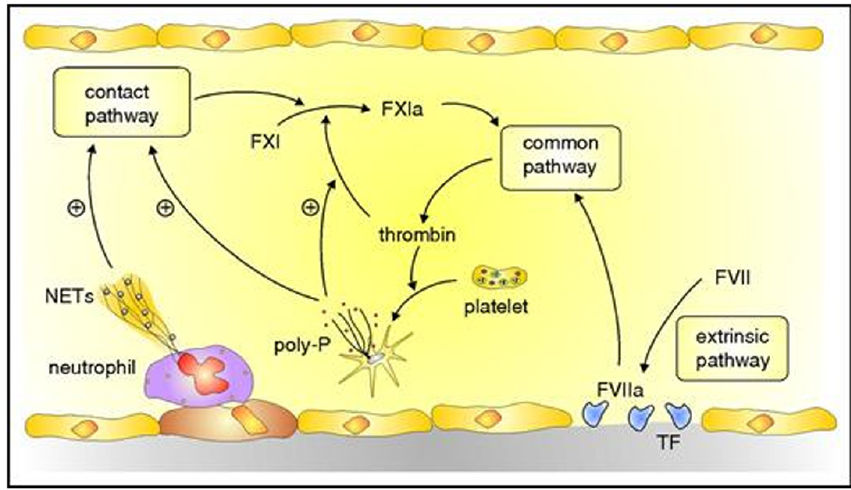
Figure 2. Initiators of coagulation. Coagulation is initiated by the extrinsic pathway when tissue factor (TF) exposed at sites of vascular injury binds and activates factor (F) VII. The FVIIa–TF complex activates FX in the common pathway to generate prothrombinase, which generates thrombin. Additional activation of coagulation occurs when thrombin-activated platelets release polyphosphate (poly-P) and activated neutrophils extrude DNA and RNA to form neutrophil extracellular traps (NETs). NETs and poly-P activate the contact pathway, which yields FXIa and leads to additional thrombin generation via the common pathway. Poly-P amplifies this pathway by promoting thrombin-mediated activation of FXI. Figure and legend reproduced with permission from the American Society of Hematology 38